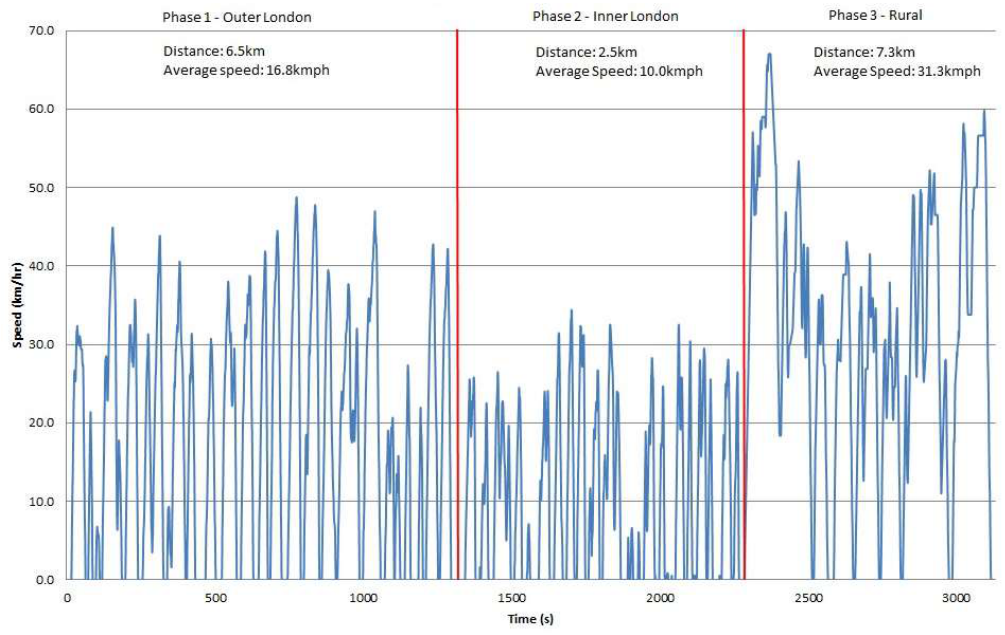
Figure 2. UK Bus test cycle (UKBC) speed-time profile.